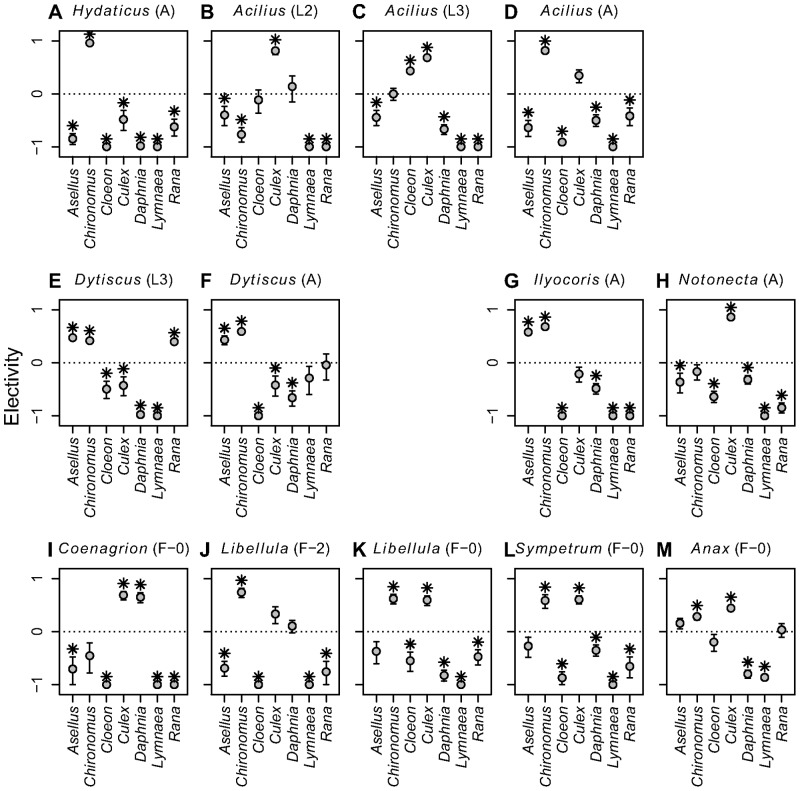
Prey selectivity of predatory aquatic insects.Mean values ± SE of electivity index are plotted. Positive values indicate preferred prey. Prey species with electivity values significantly different from zero (P<0.05, Holm’s correction of P-levels within each predator species was used) are marked by asterisk. Predator stage as in Table 1. Panels are sorted taxonomically: A–F = Coleoptera, G–H = Heteroptera and I–M = Odonata.